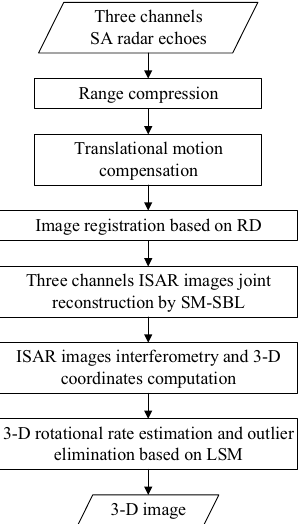
Figure 2. Flowchart of sparse-aperture interferometric inverse synthetic aperture radar (SA-InISAR) imaging sequential multiple sparse Bayesian learning (SM-SBL).